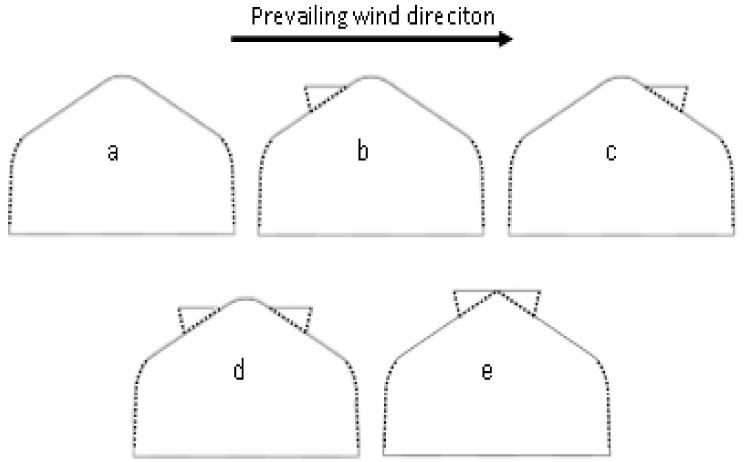
Figure 4. High tunnel vent configurations: ( a ) roll-up side vents only; ( b ) with added windward roof vent; ( c ) with added leeward roof vent; ( d ) with added windward and leeward roof vents; and ( e ) with added center ridge